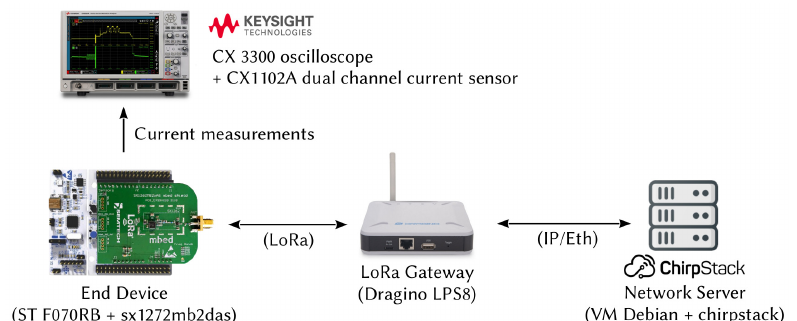
Figure 8. Scheme of the experimental testbed.